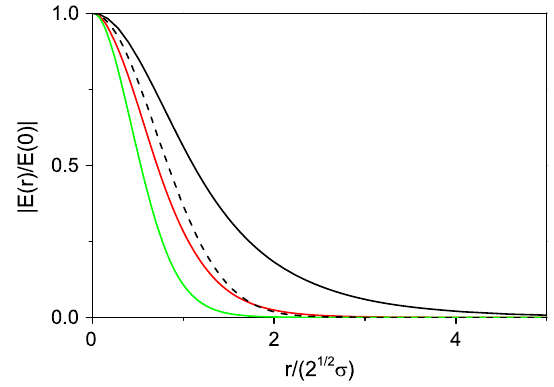
FIG. 8. Field amplitude of the FEL radiation mode in the high gain linear regime. Black, red, and green colors correspond to the value of the diffraction parameter B ¼ 1 , 10, and 40, respectively. The dashed line shows the profile of the beam current density exp ½ − r 2 = ð 2 σ 2 Þ(cid:2)